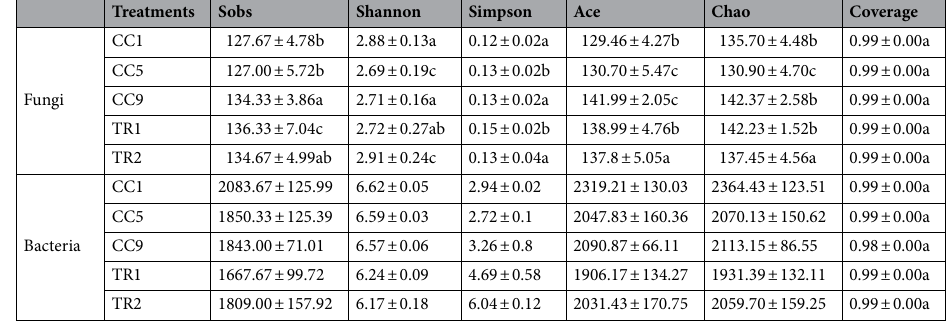
Table 3. Alpha-diversity indexes of fungi and bacteria in different continuous pepper cropping soils. CC1, CC5 and CC9, represent the plots where pepper had been continuously planted for 1, 5 and 9 years, respectively, and TR1 and TR2 represent CC9 plots in which the MHT1134 biocontrol fermentation broth had been applied 1 and 2 years in advance, respectively. The data are mean ± SD. The different lowercase letters in the same column indicate significant different at P < 0.05 level by Duncan’s new multiple range